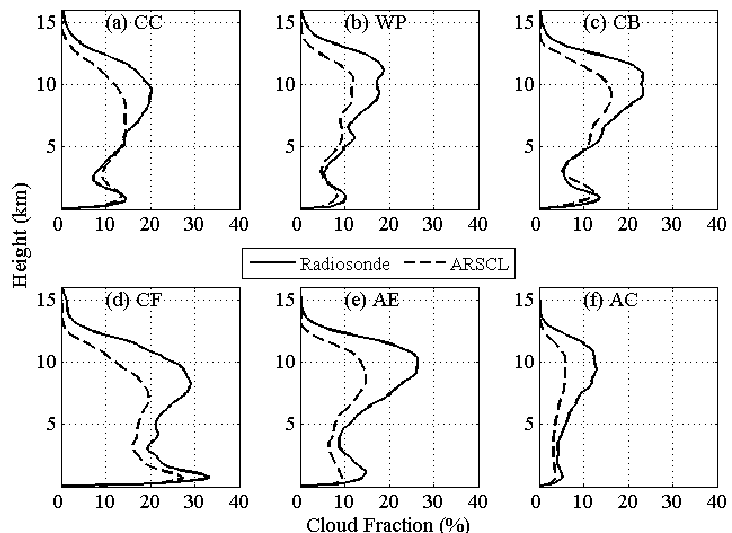
Figure 6. Average profiles of vertical cloud fraction derived from the radiosonde data (solid line) and ARSCL product (dashed line) for the synoptic patterns of: CC ( a ); WP ( b ); CB ( c ); CF ( d ); AE ( e ); and AC ( f ) during 2001–2010 at the SGP site. The vertical resolution is 100 m.